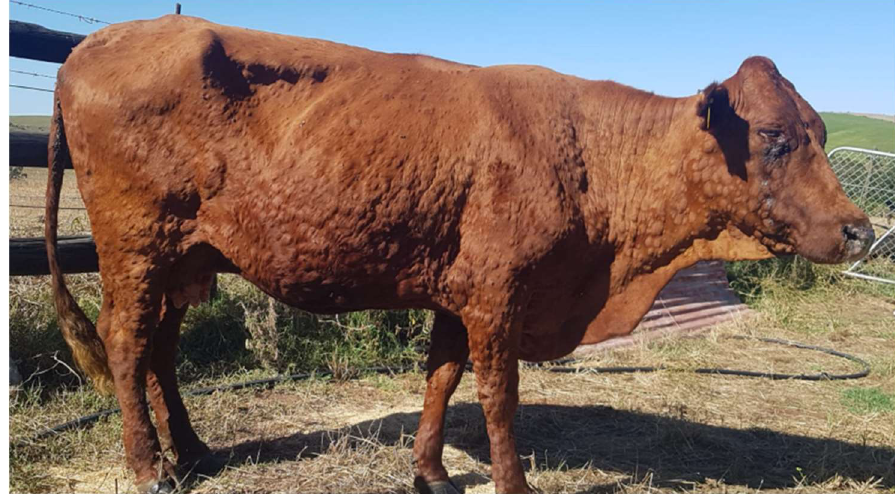
Figure 2. Bonsmara cow with lumpy skin disease—photograph provided by P. B. Kloppers.